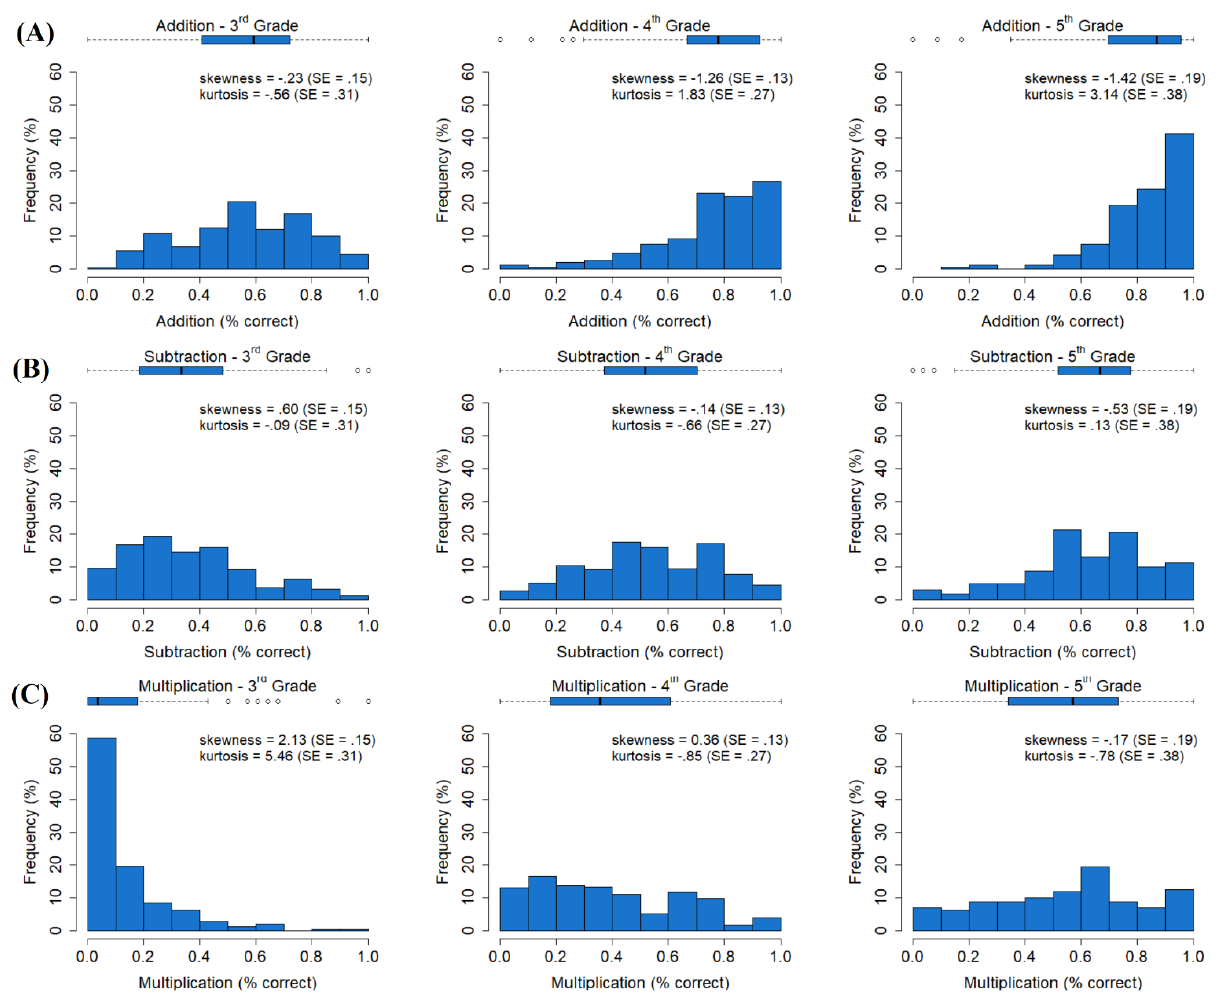
Figure 1. Children’s performance on addition, subtraction, and multiplication operations across